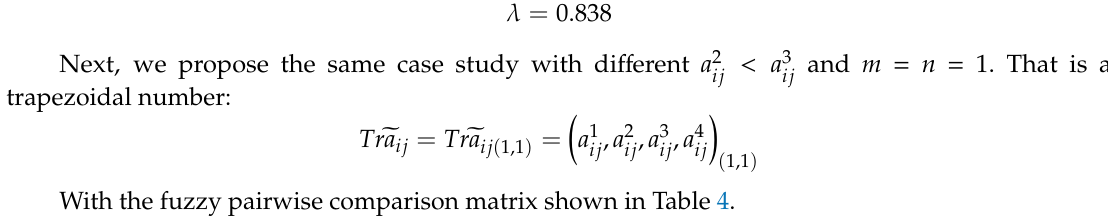
Table 4. Fuzzy pairwise comparison matrix using Tr (cid:101) a ij ( m , n ) when a 2 Goal Pricing Service Quality